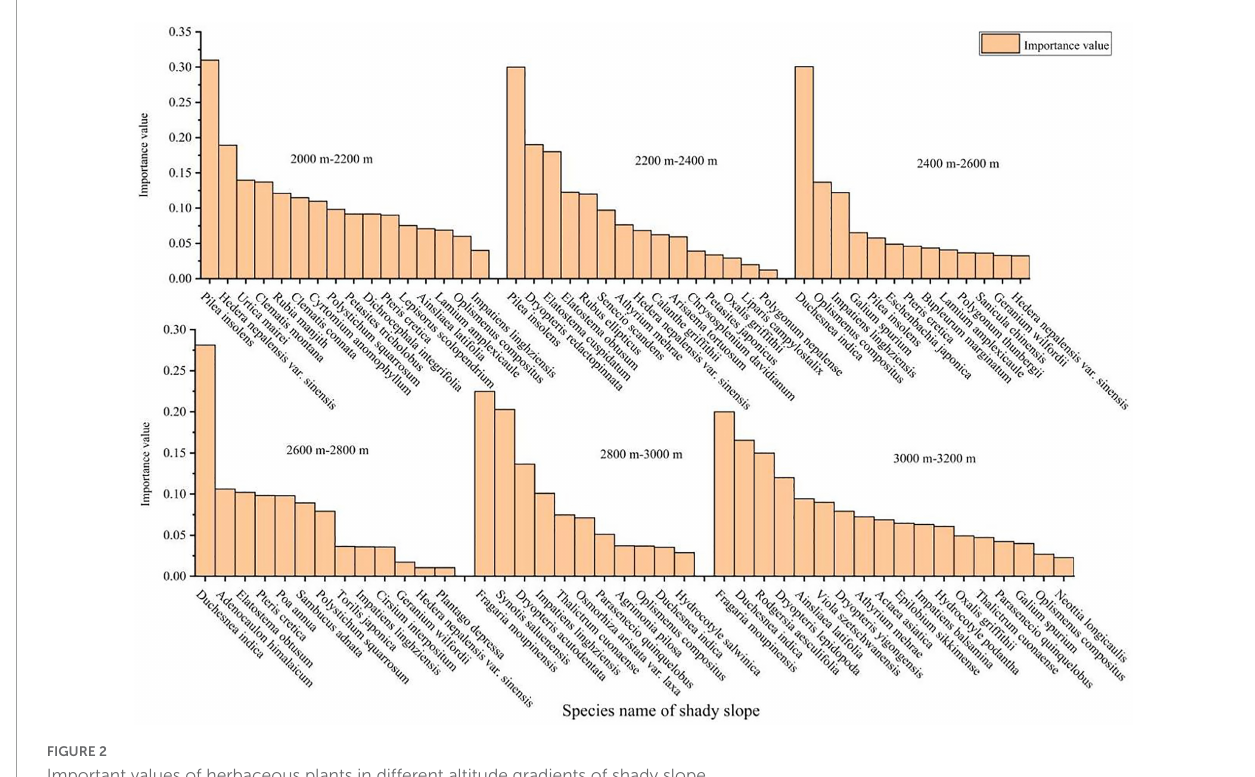
FIGURE2 Important values of herbaceous plants in different altitude gradients of shady slope.